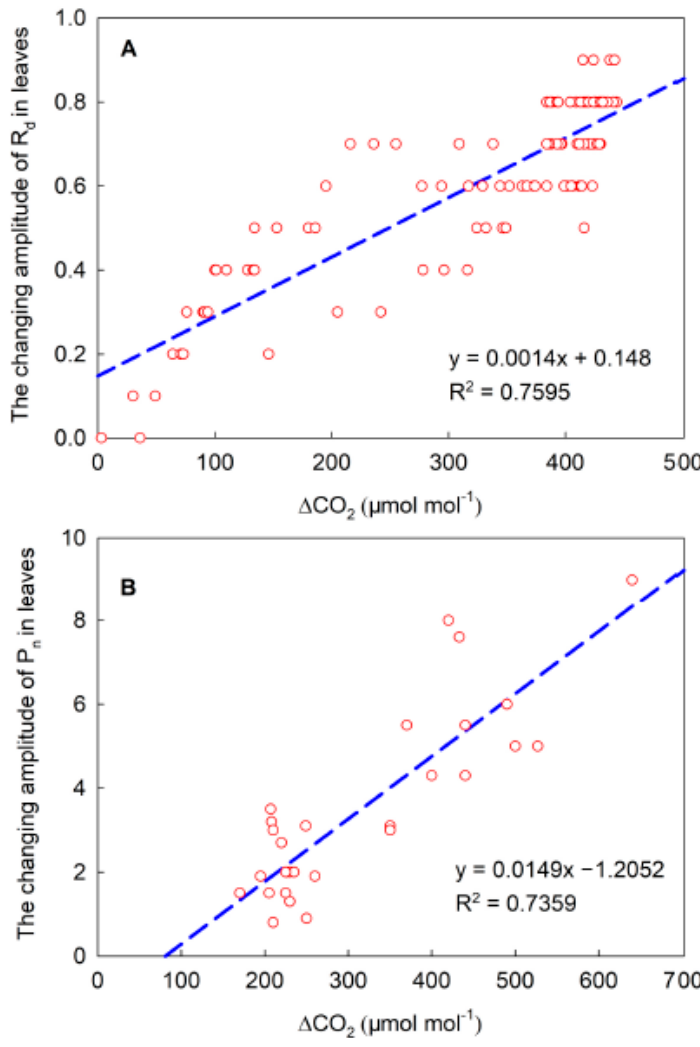
Figure 9. Linear correlation between Δ CO 2 (CO 2 pressure difference) and the changing amplitude of lateral CO 2 diffusion. ( A ) R d of maize and sorghum leaves; ( B ) P n of various plant species, including maize, sorghum, cotton, sunflower, cucumber, soybean, and spinach.